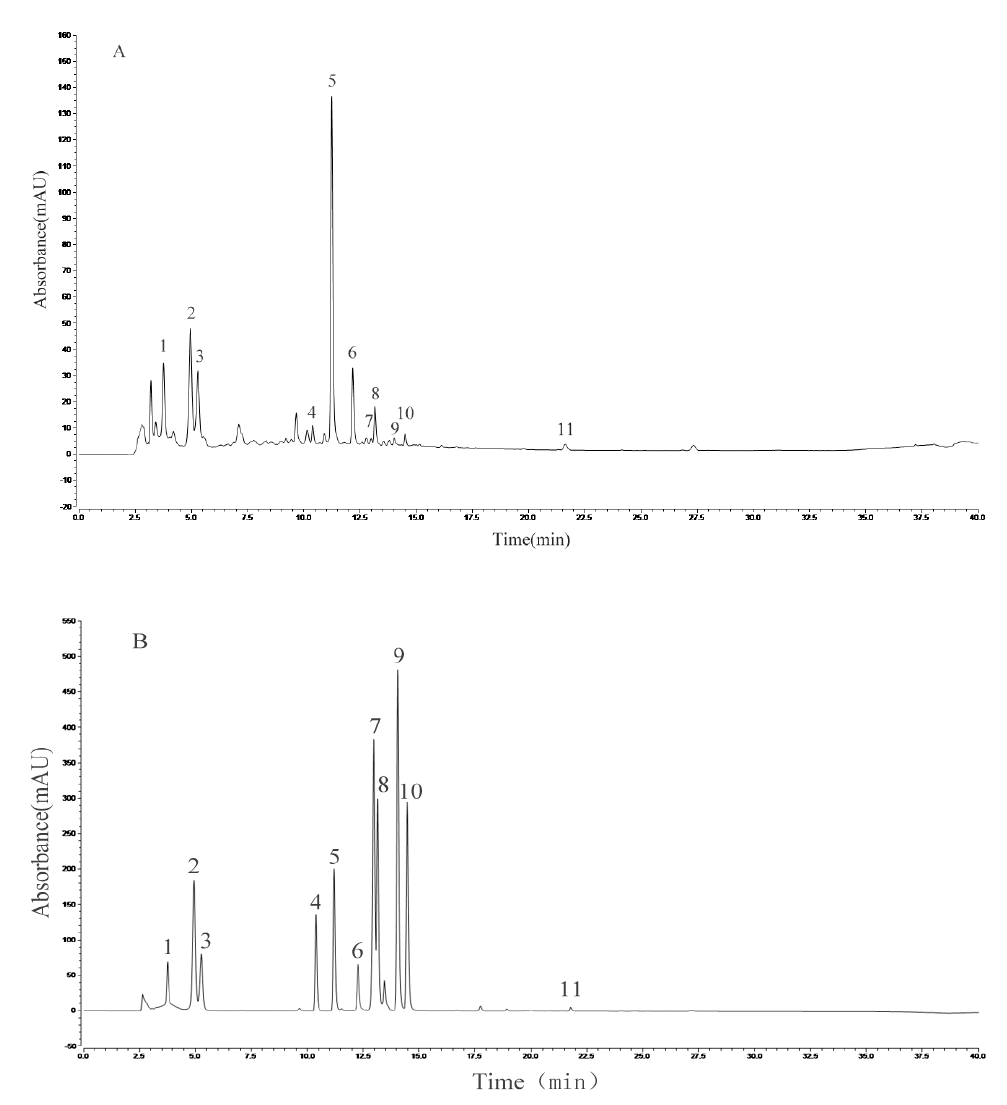
Figure 6. Analysis of the constituents of AVTE via high performance liquid chromatography (HPLC) assay. ( A ) AVTE chromatogram; ( B ) standard chromatograms.